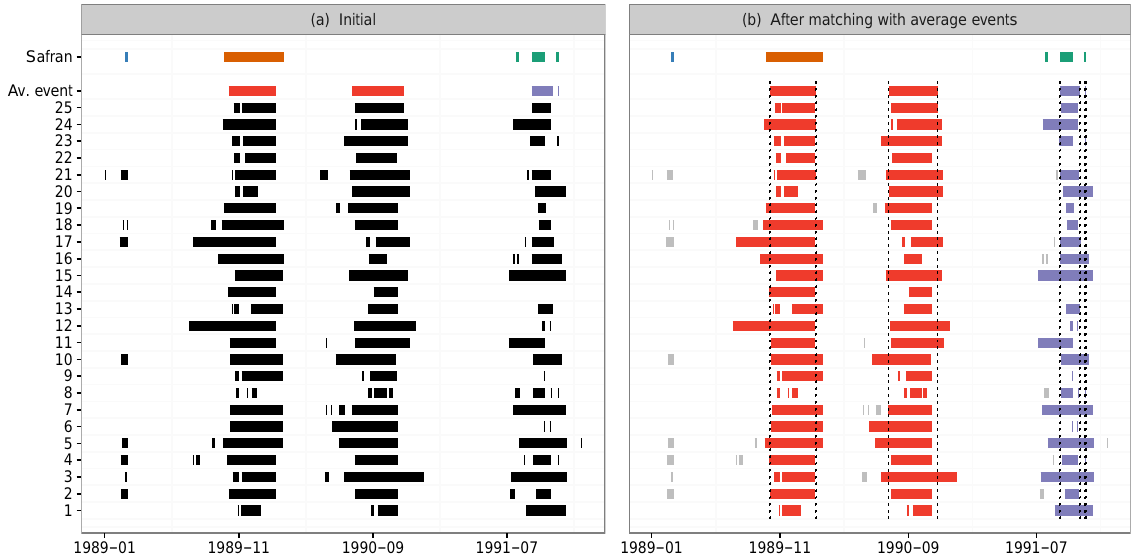
Figure 8. Ensemble spatial matching for Station 1 in HER 11 during the 1989–1991 period. Events from Safran Hydro, average event series, and the 25 members of SCOPE Hydro are represented. (a) Each colour defines one spatio-temporal event for Safran Hydro and average series. Events from average series and Safran Hydro are independently spatially matched, leading to different colours (not the same datasets). Black bars are independent local events from the 25 members of SCOPE Hydro. (b) Matching between the 25 event members from SCOPE Hydro and average events. Grey events not overlapping average events are considered probabilistic noise and are removed from the dataset. Dashed lines are set at the start and end dates of each average